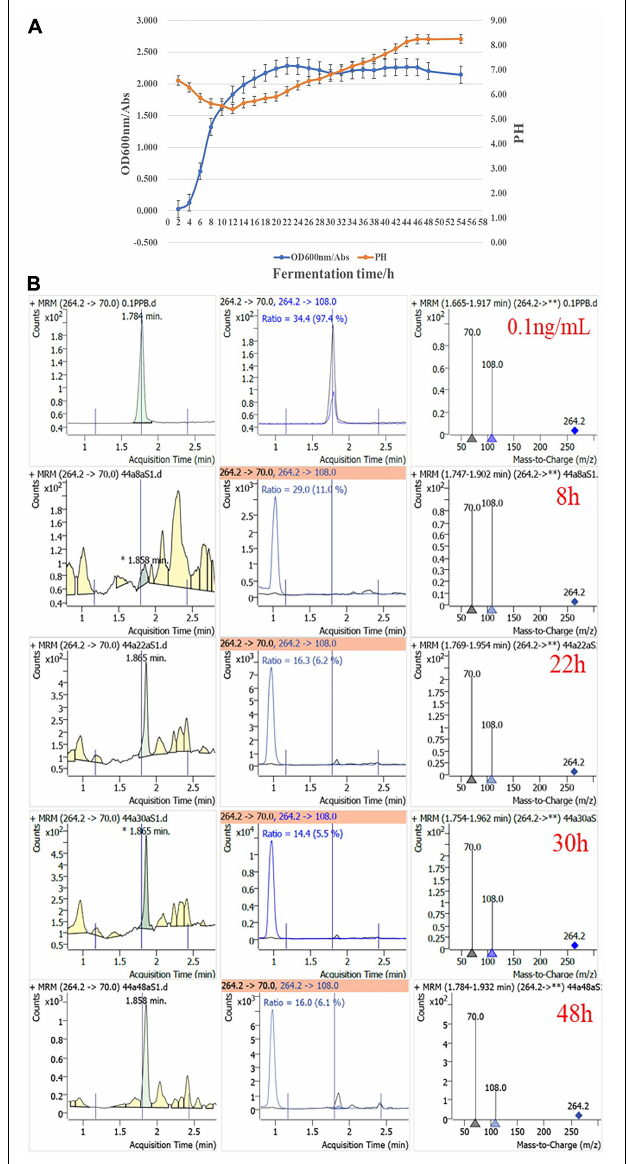
FIGURE 6 | (A) Growth curves of strain CM-YJ10_15-44. Error bars represent standard error ( n = 3). (B) UHPLC-QqQ-MS/MS detection results of dendrobine in fermentation supernatant from strain CM-YJ10_15-44 at different time points. 0.1 ng/ml represents concentration of dendrobine standard was 0.1 ng/ml (8 h represents culture supernatant of strain CM-YJ10_15-44 after fermentation for 8 h; 22 h represents culture supernatant after fermentation for 22 h; 30 h represents culture supernatant after fermentation for 30 h; 48 h represents culture supernatant after fermentation for 48 h).